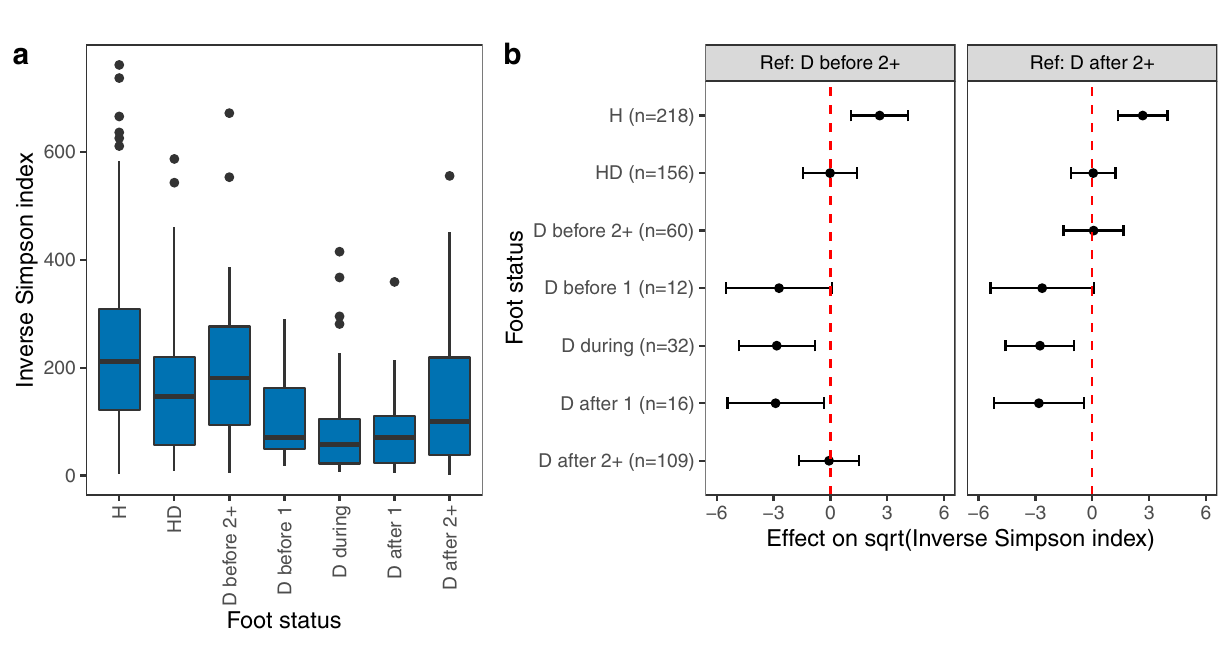
Figure 4. Diversity of the interdigital skin microbiota is temporally associated with footrot. ( a ) Boxplots of Inverse Simpson index in samples from all sheep by foot status. ( b ) Effects of foot status on square root transformed Inverse Simpson index as quantified by linear mixed-effects models. Centres indicate estimated fixed effects with error bars showing 95% confidence intervals. The foot status category used as the reference category in each model is shown above each plot. H = healthy foot of healthy sheep; HD = healthy foot of diseased sheep; D = diseased foot: before 2 + = ≥ 2 weeks before footrot episode; before 1 = 1 week before footrot episode; during = during any footrot episode in that foot; after 1 = 1 week after footrot episode, after 2 + = ≥ 2 weeks after footrot episode. Number of samples (n) =